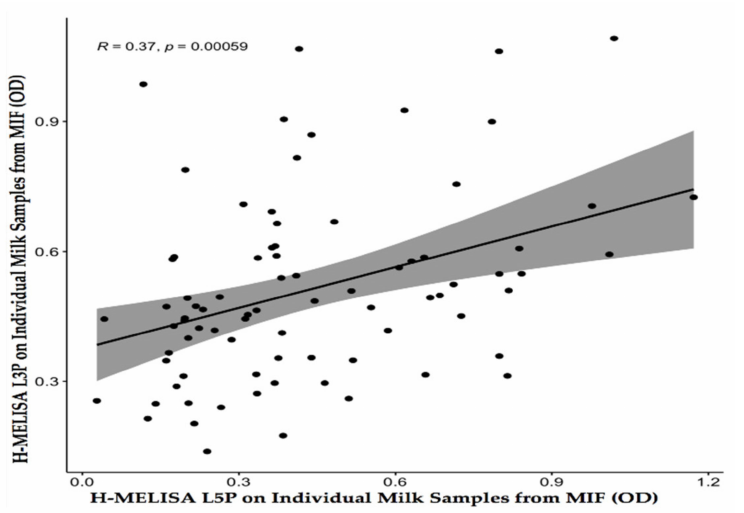
Figure 2. Pearson correlation test between the two H-MELISA analyses via the two MAP-derived lipopeptides of L3P and L5P on 81 individual milk samples from a MAP-infected flock (MIF) of sheep ( r (degree of freedom = 79) = 0.37, p =